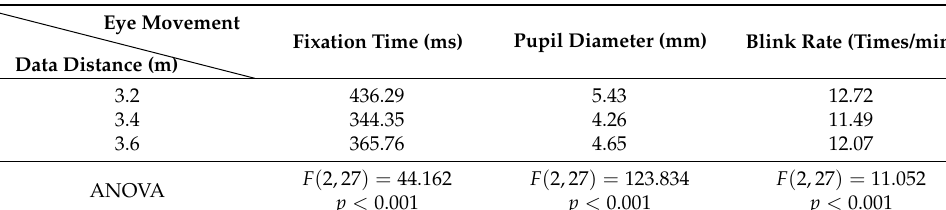
Figure 12. Time variation trend of the overall situational awareness information to complete tasks at different depths and distances.